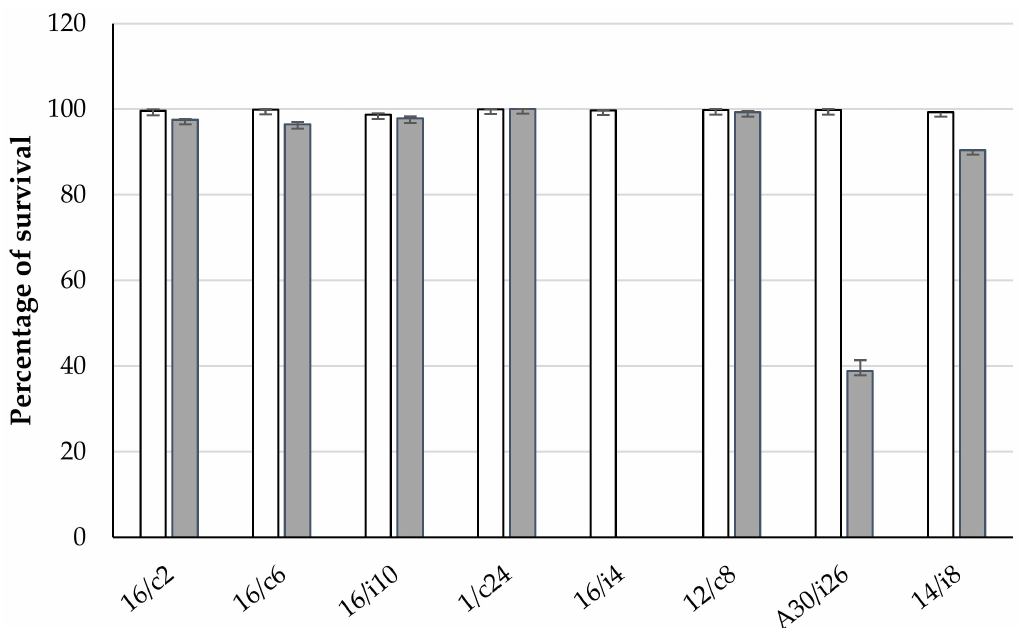
Figure 4. Effects of simulated gastrointestinal conditions on lactobacilli viability. White and grey columns correspond to lactobacilli subjected to 0.15% and 0.3% bile salts, respectively. L. crispatus 16/c2, Ligilactobacillus salivarius (16/c6, 16/i4, A30/i26, 14/i8), Lactobacillus sp. 16/i10 and Limosilacto- bacillus reuteri (1/c24 and 12/c8).